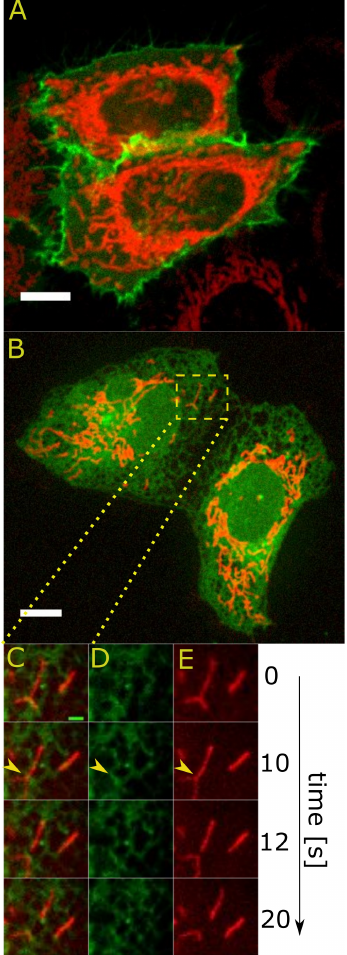
Figure 1. Image of plasma membrane (PM) (green) and mitochondria (red) in HeLa cells. Cells were transfected with pCAG-mGFP (for staining the PM) and mito-mNeptune (for staining the mitochondria). ( A ) Image of the endoplasmic reticulum (ER) (green) and mitochondria (red) in U2OS cells. The cells were transfected with pAc-GFPC1-Sec61- β plasmid (for staining the ER) and mito-mNeptune (for staining the mitochondria); ( B ) An example of a fission event is shown in the enlarged inset region (four selected images from the time series acquired with a 2-s time step). The fission event takes place between the time points of 10 and 12 s. The localization of the fission event is indicated with a yellow arrow in each channel (( C ) overlay, ( D ) ER, ( E ) mitochondria). The ER structure is clearly visible at the fission site. Imaging was performed using Zeiss spinning disc microscope. The white scale bar in ( A ) and in ( B ) corresponds to 10 µ m; the green scale bar in ( C ) corresponds to 2 µ m. Experiments were performed with similar procedures as reported elsewhere